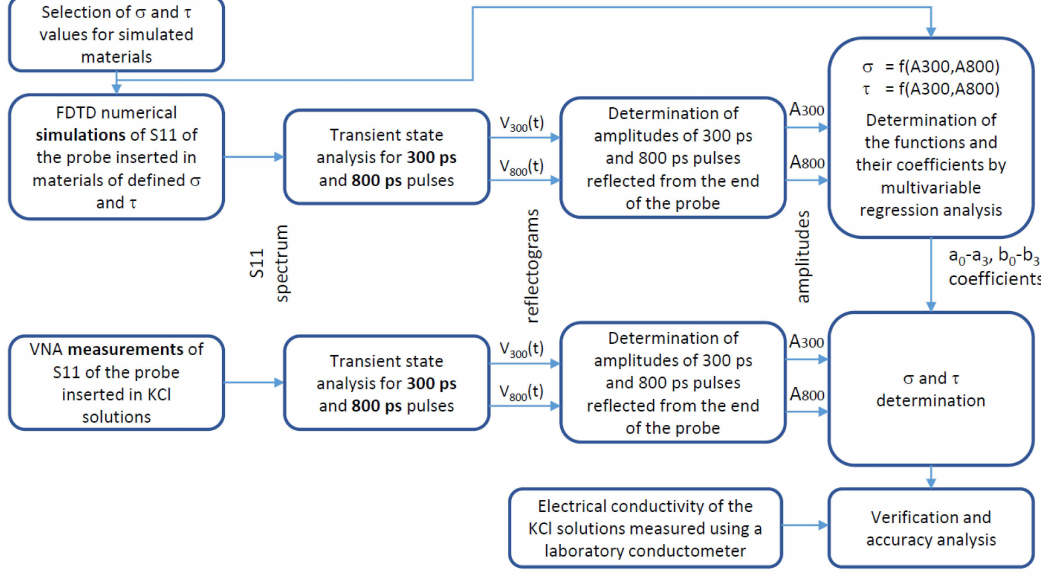
Figure 4. The workflow diagram of the presented